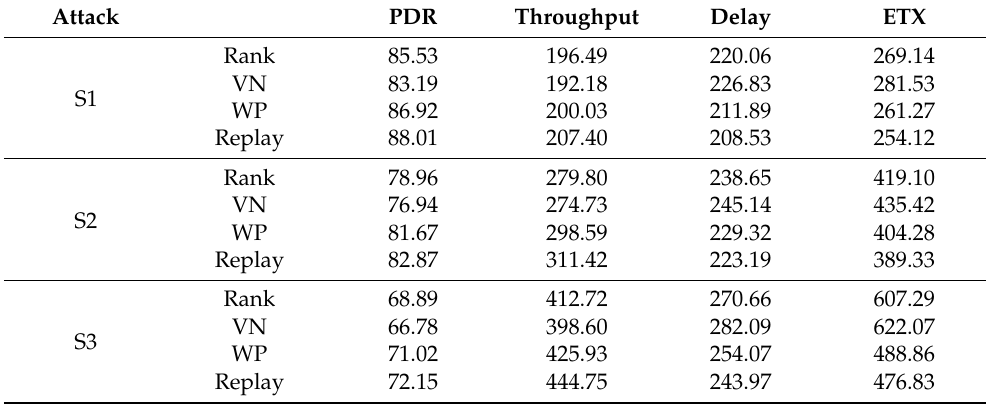
Table 5. QoS Performance Results: Composite-Attack Scenario.